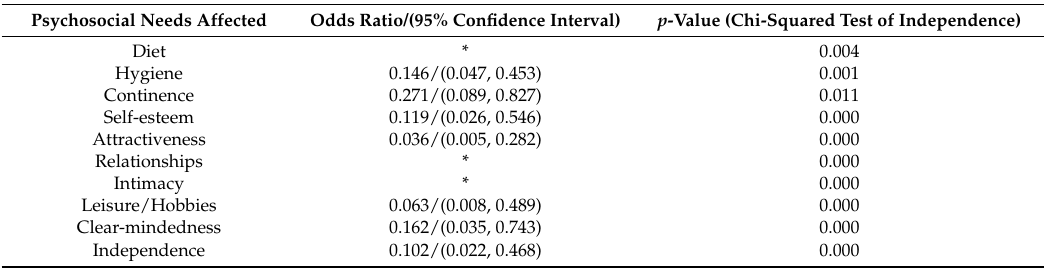
Table 5. Bivariate analysis of psychosocial health with participants’ illness